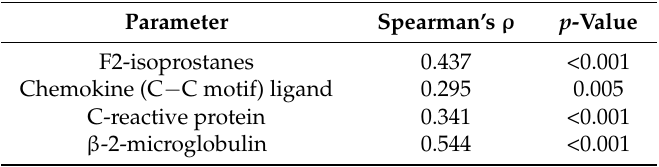
Correlations between plasma galectin-3 concentrations and the other selected biochemical